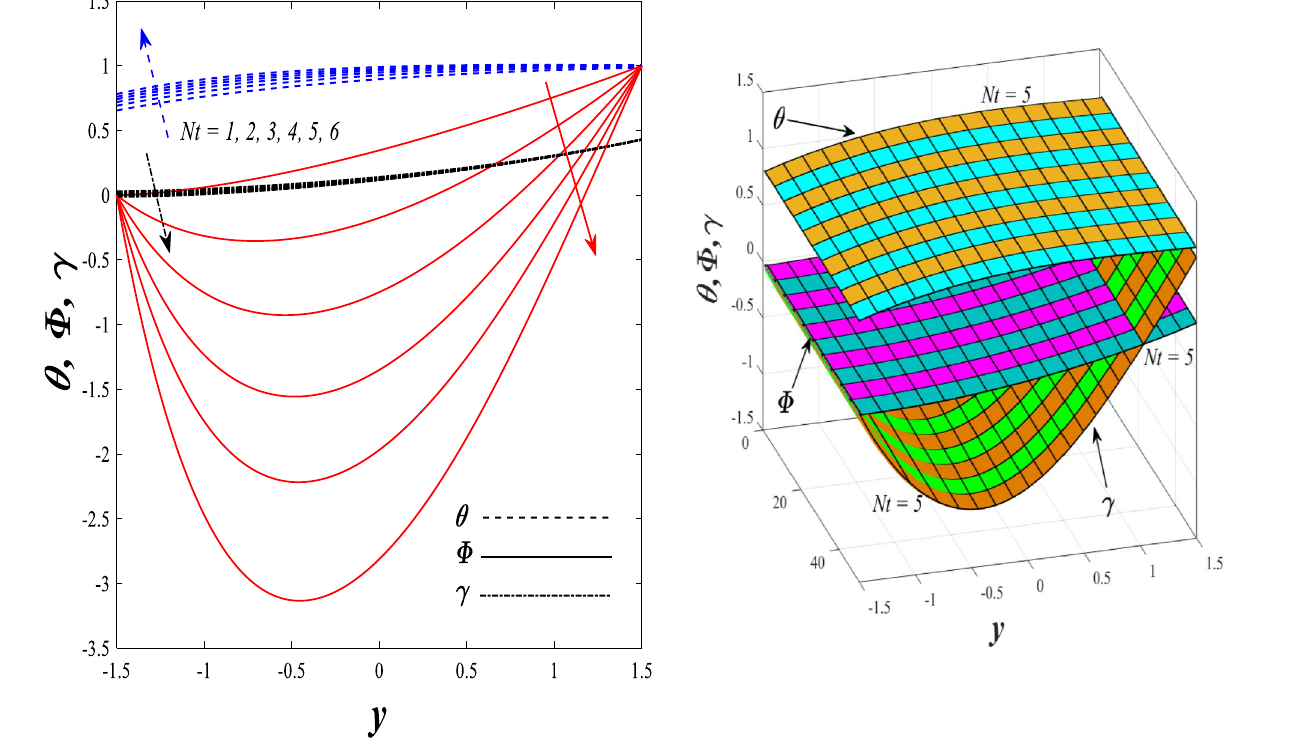
Figure 14. Effect of thermophoresis parameter Nt on the distributions of both temperature, solutal concentration and nanoparticles volume fraction 2D and 3D.